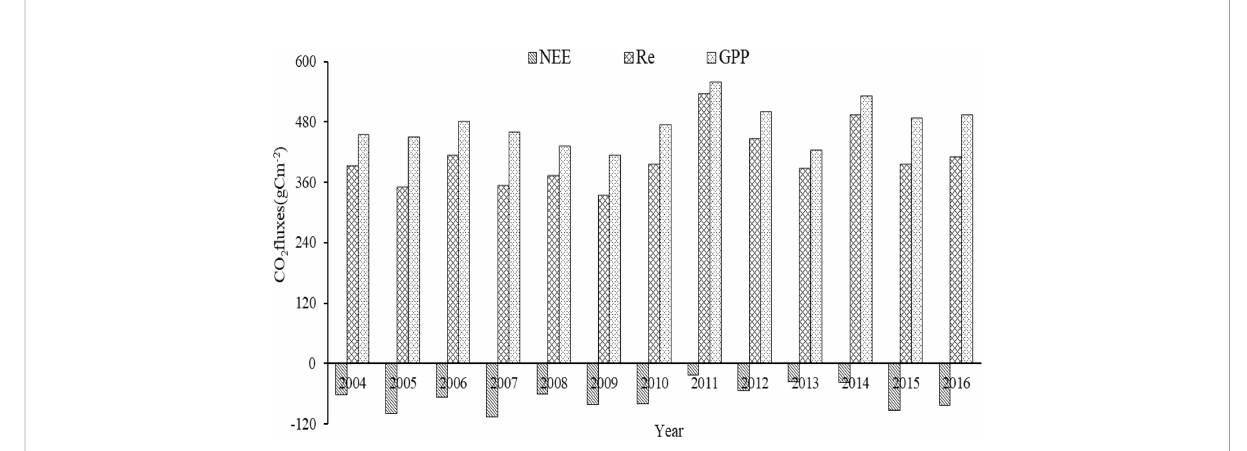
FIGURE 4 The annual CO 2 fl uxes of alpine wetland in the growing season for the period